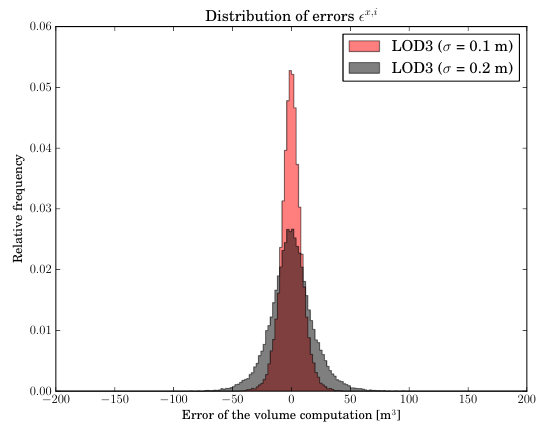
Figure 9: Distribution of volume errors in the accuracy classes σ = 0.1 and 0.2 for LOD3. Note that here the selection of the classes is different, since in LOD3 they have been